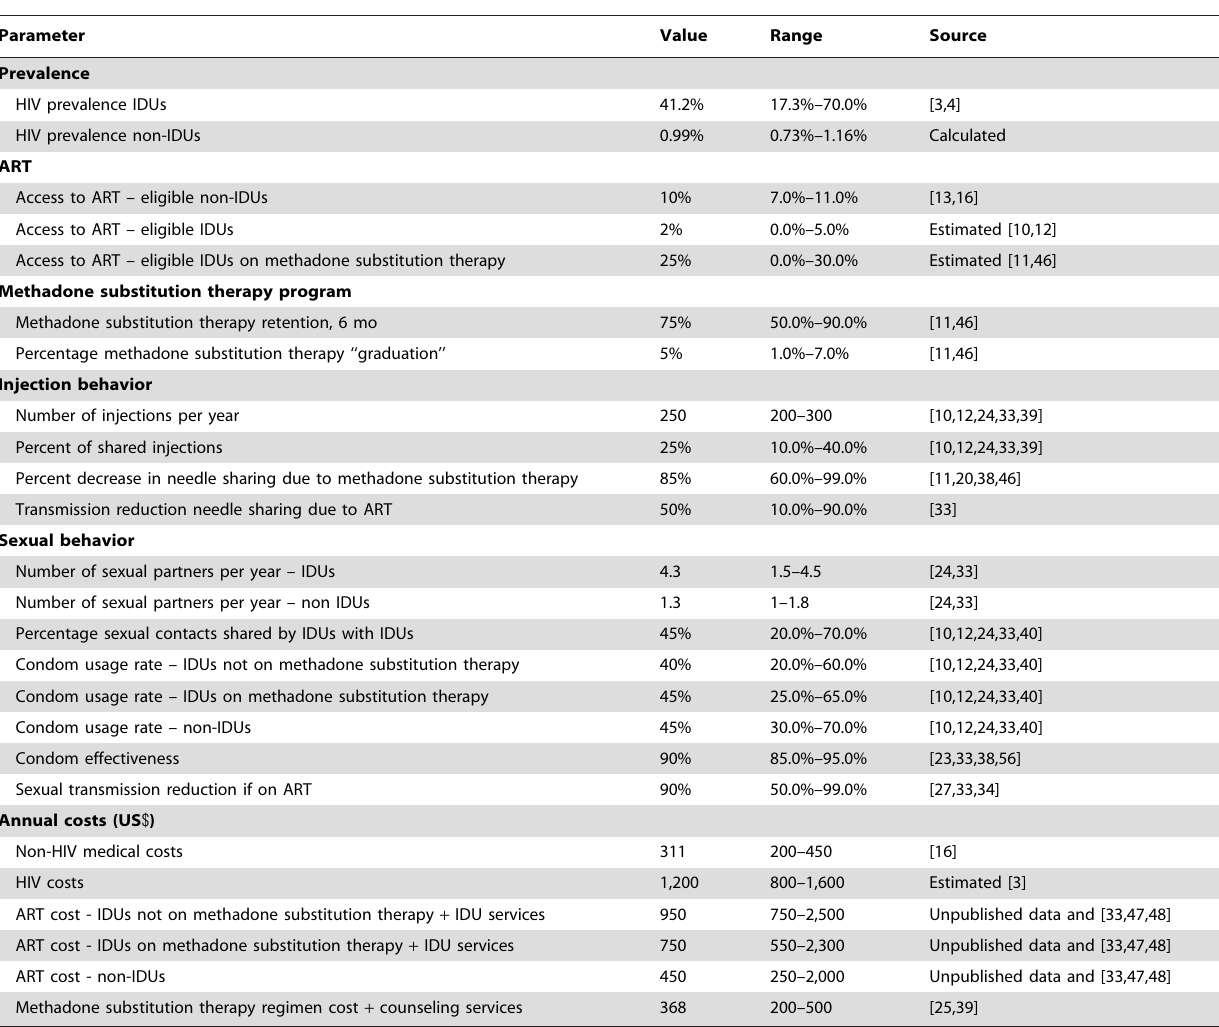
Table 1. Key parameter values, ranges, and